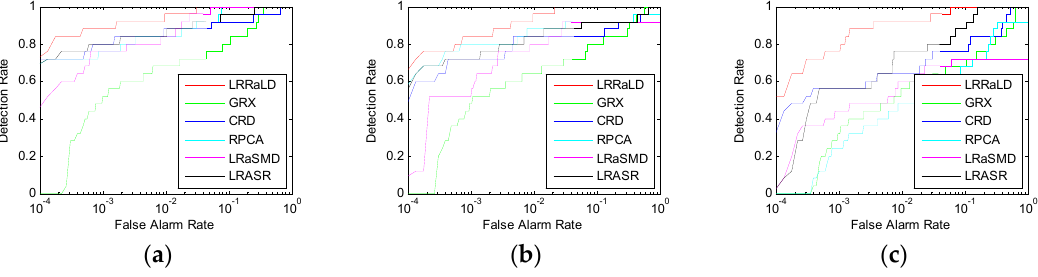
Figure 11. ROC curves under simple background using different methods: ( a ) F1; ( b ) F2; and ( c ) V1.